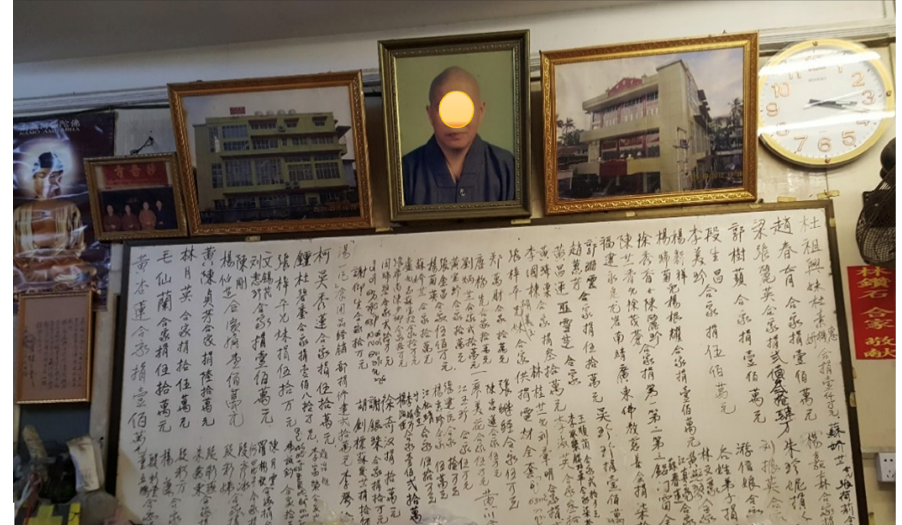
Figure 8. Hand-written donors’ names and donated amounts (Source: Author).